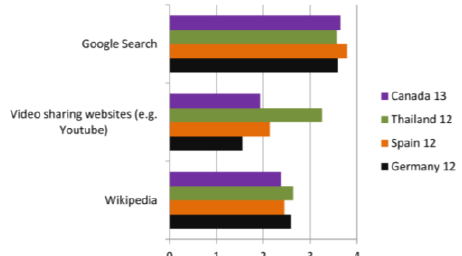
Figure 15. Students from four selected universities,